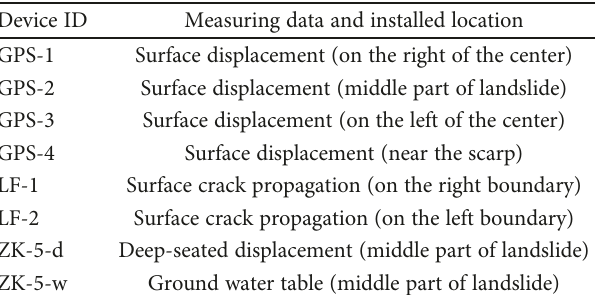
Figure 4: Distribution of monitoring devices on Hongyanzi landslide. Table 1: Monitoring devices employed in this study.